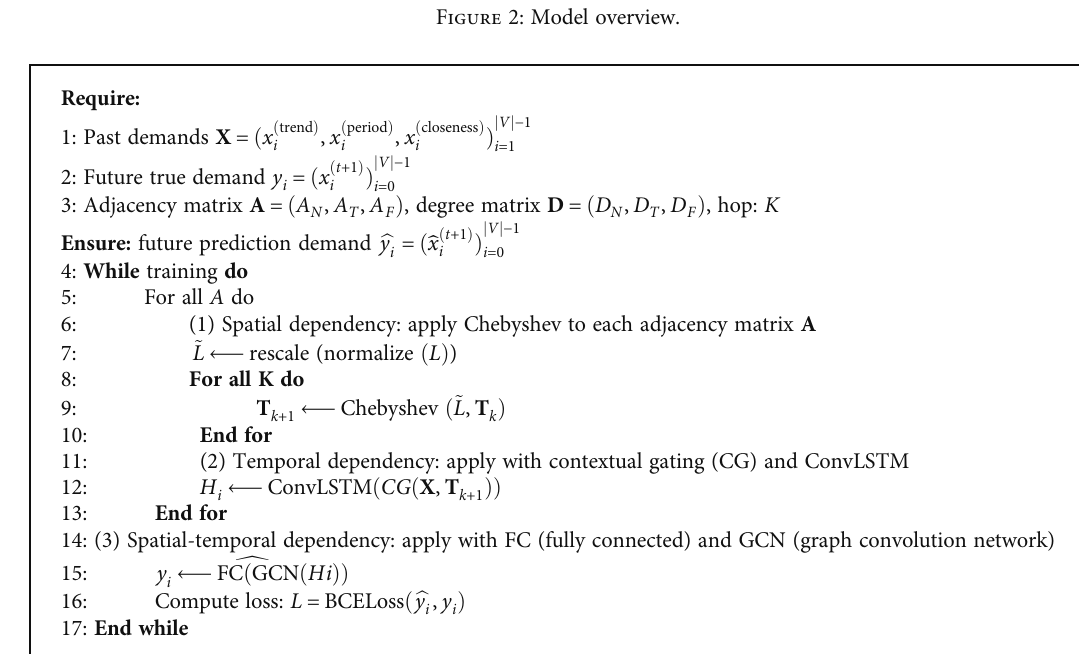
Algorithm 1: Training procedure of the proposed